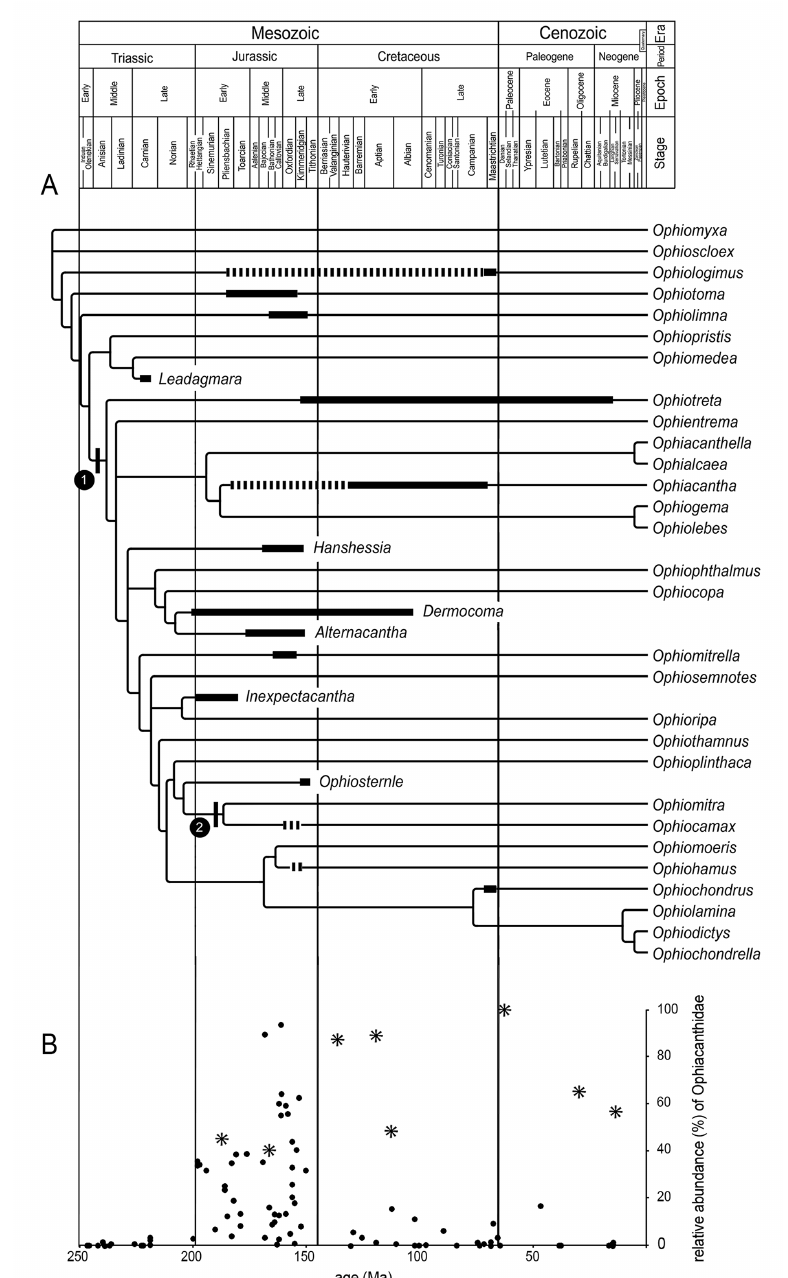
Fig. 3. A. Evolutionary tree of the Ophiacanthidae based on the reweighed dataset tree of Fig. 2B. Calibration is based on nodes marked as 1 (oldest occurrence of small tentacle pores, Europacantha paciphila sp. nov. from the Anisian of Hungary) and 2 (oldest occurrence of lateral arm plate morphology exclusively found in the Ophiomitra - Ophiocamax clade, Reitneracantha dissidens sp. nov. from the late Sinemurian to early Pliensbachian of Austria), and on the first occurrences of a number of extinct genera ( Leadagmara Thuy et al. , 2012, Dermocoma Hess, 1964, Inexpectacantha Thuy, 2011). Thick lines indicate the observed fossil record of the actual genus, doted lines denote the fossil record of a genus within the same lineage (e.g. Lapidaster sp. nov. in Ophiologimus H.L. Clark, 1911), and thin lines are the expected ranges. B. Relative abundances of the Ophiacanthidae in shallow (< 200 m palaeodepth, small dots) and deep (> 200 m palaeodepth, asterisks) environments through